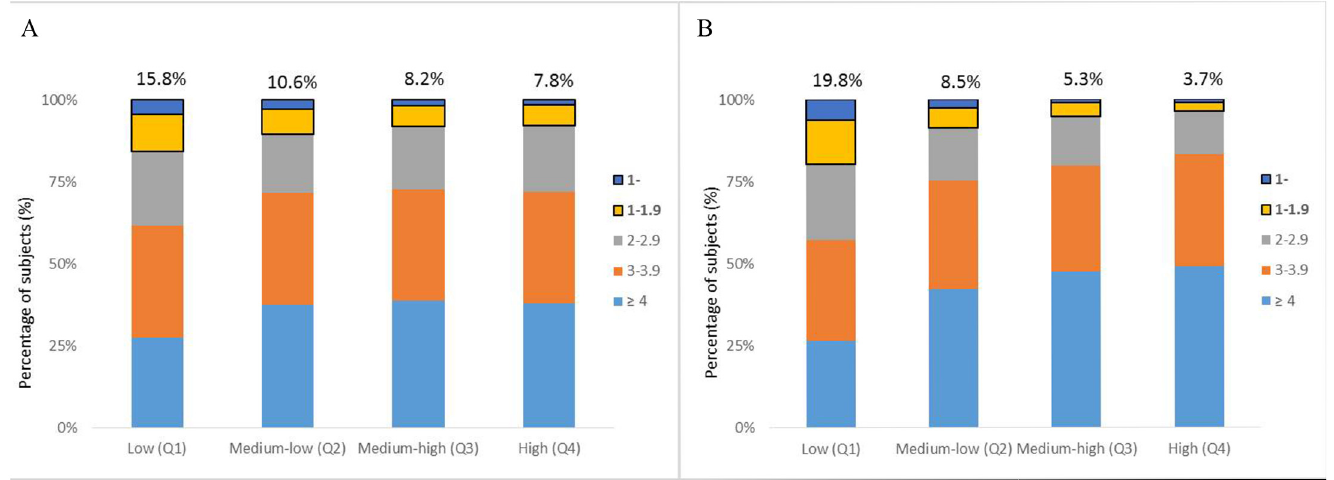
Fig 1. The prevalence of blepharoptosis by MRD 1 measurement according to level of household income. Household income was divided into quartiles and defined as low (Q1), medium-low (Q2), medium-high (Q3), and high (Q4) in men (A) and women (B). MRD, marginal reflex distance. P -value for trend < 0.001.